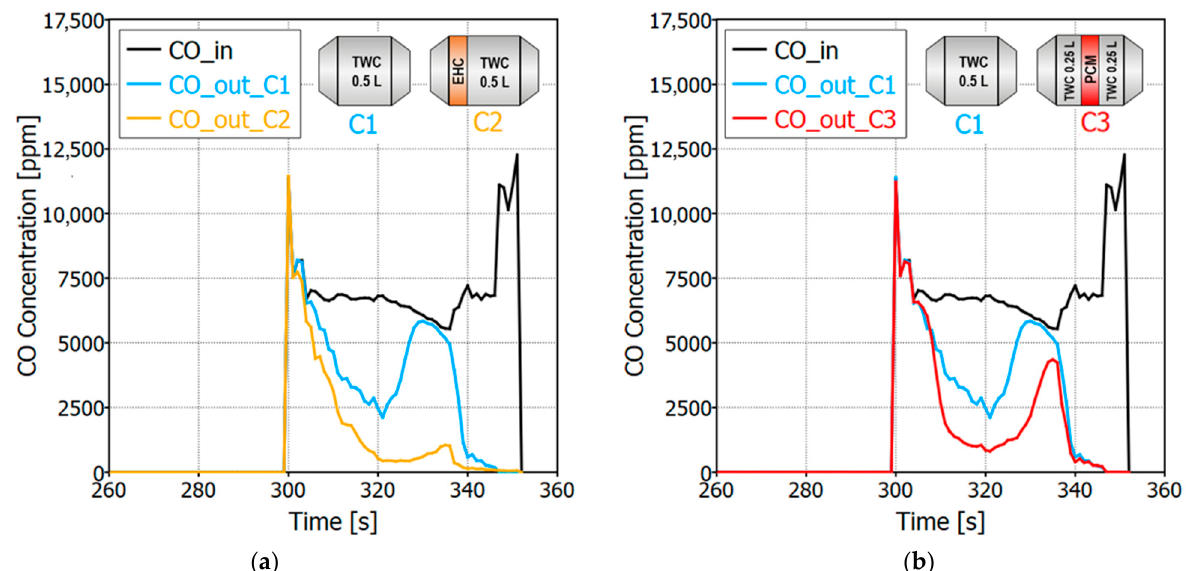
Figure 21. Predicted CO emissions after 5 min of soaking time. ( a ) Effect of EHC (C2); ( b ) Effect of embedded PCM (C3).